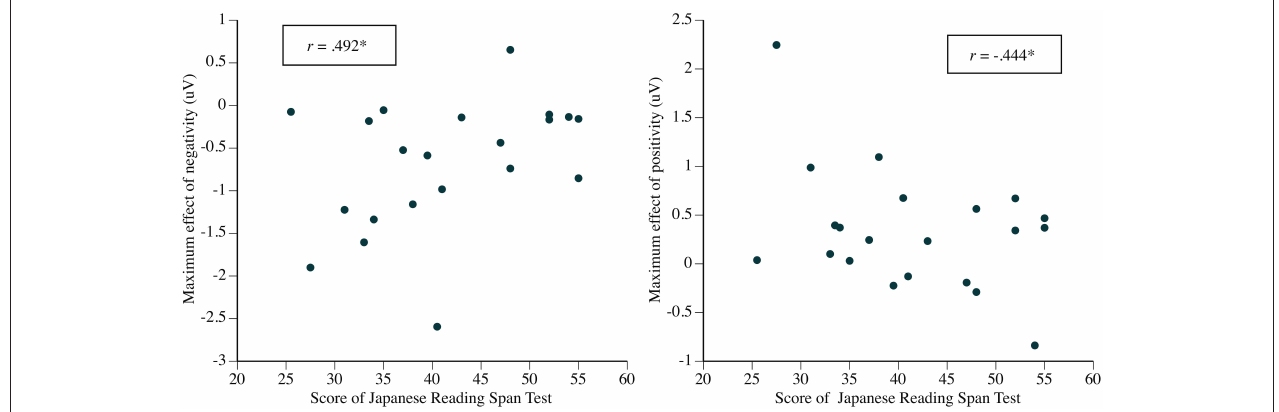
FIGURE 10 | The relationships between the ERP effects and the Japanese Reading Span scores across participants for syntactic integration. Each point represents one participant. The maximum effects are the differences between Distant and Adjacent of Quantifier First in Table 3 .